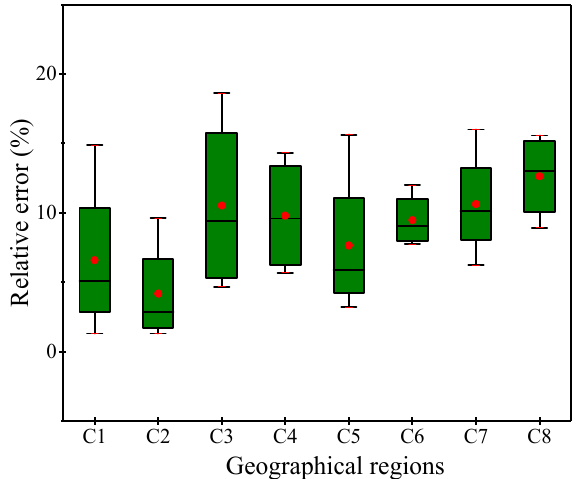
Figure 2. Relative error analysis between SOC measured value and estimated value.